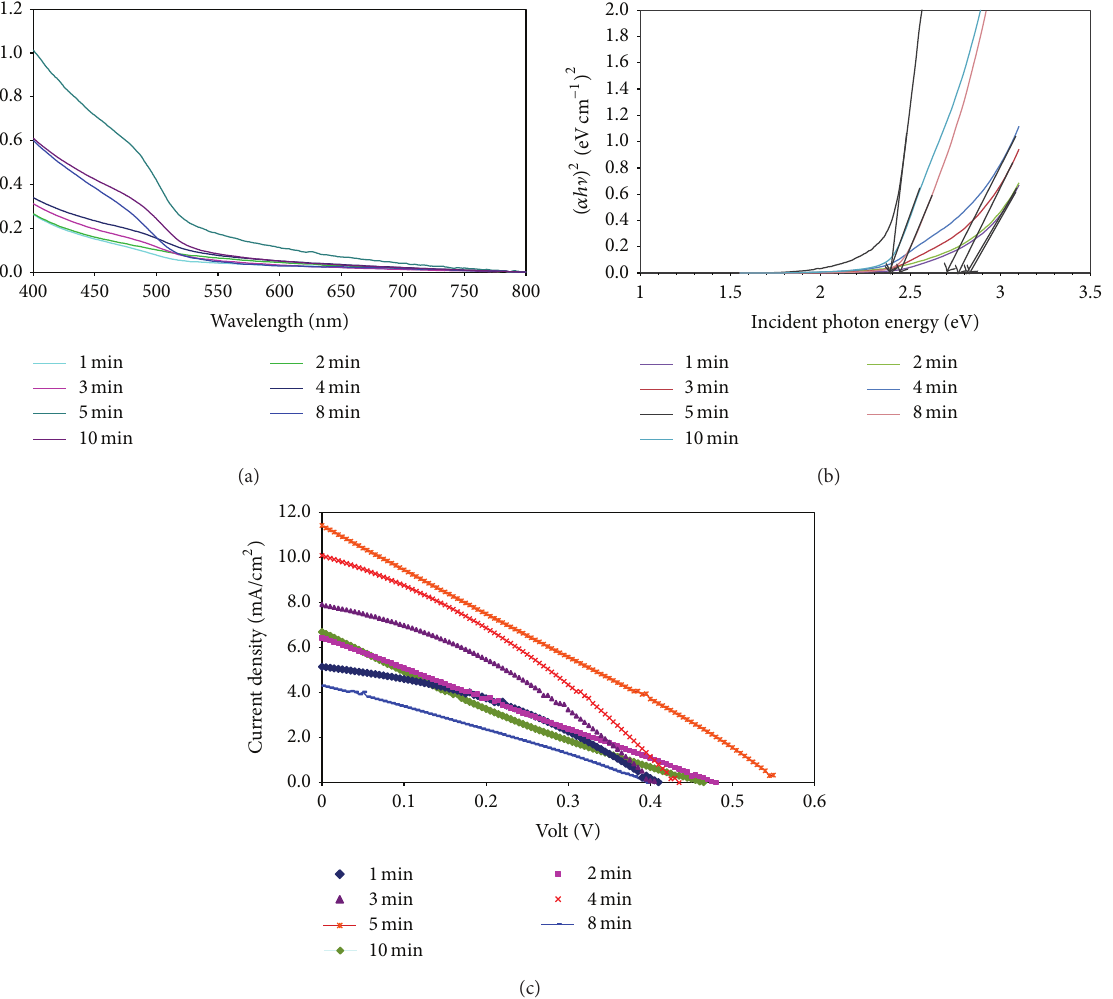
Figure 6: (a) UV-vis spectra, (b) Tauc plot, and (c) J-V curves of QDSSC for CdS QDs prepared using different dipping times.